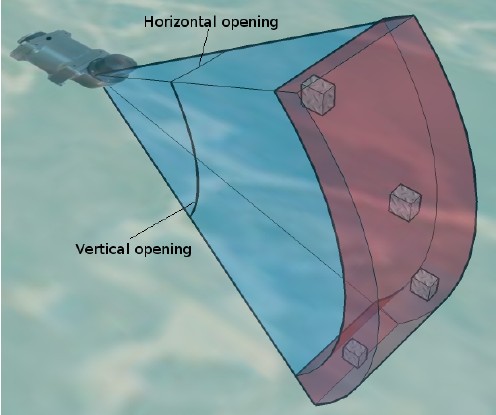
Figure 3. Uncertainty in object detection. All the depicted obstacles (boxes) produce the same measurement (in red) as they are at the same distance to the